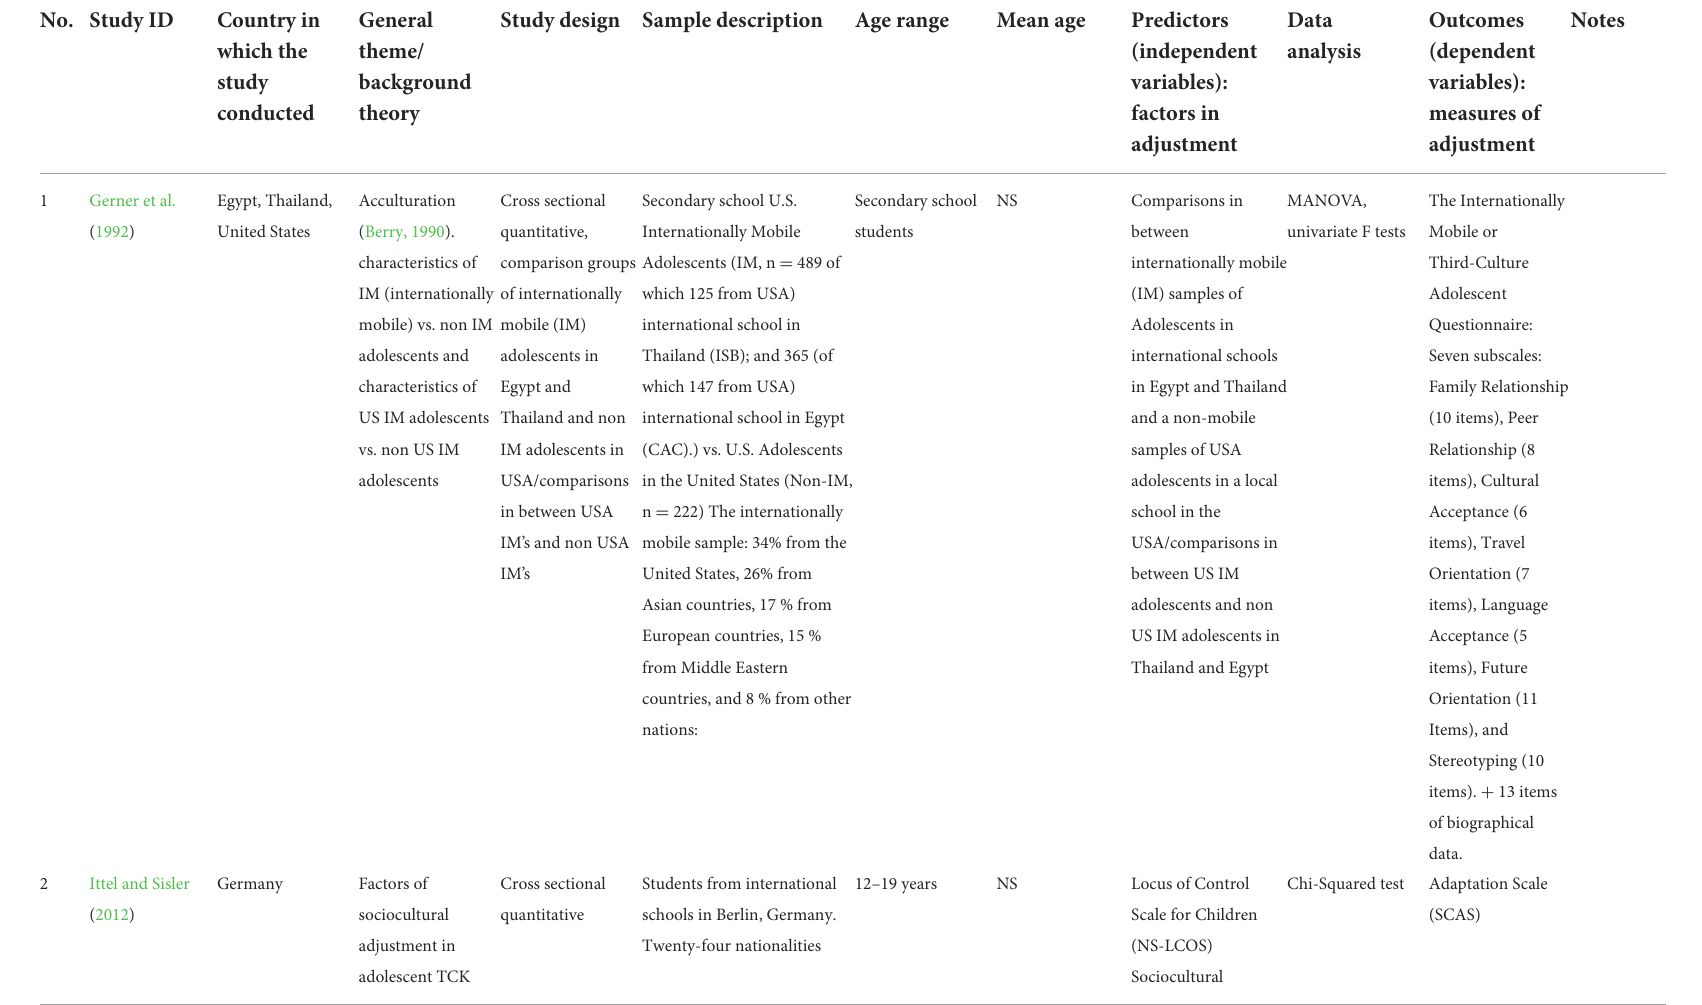
TABLE 3 Descriptives and prominent findings in extracted